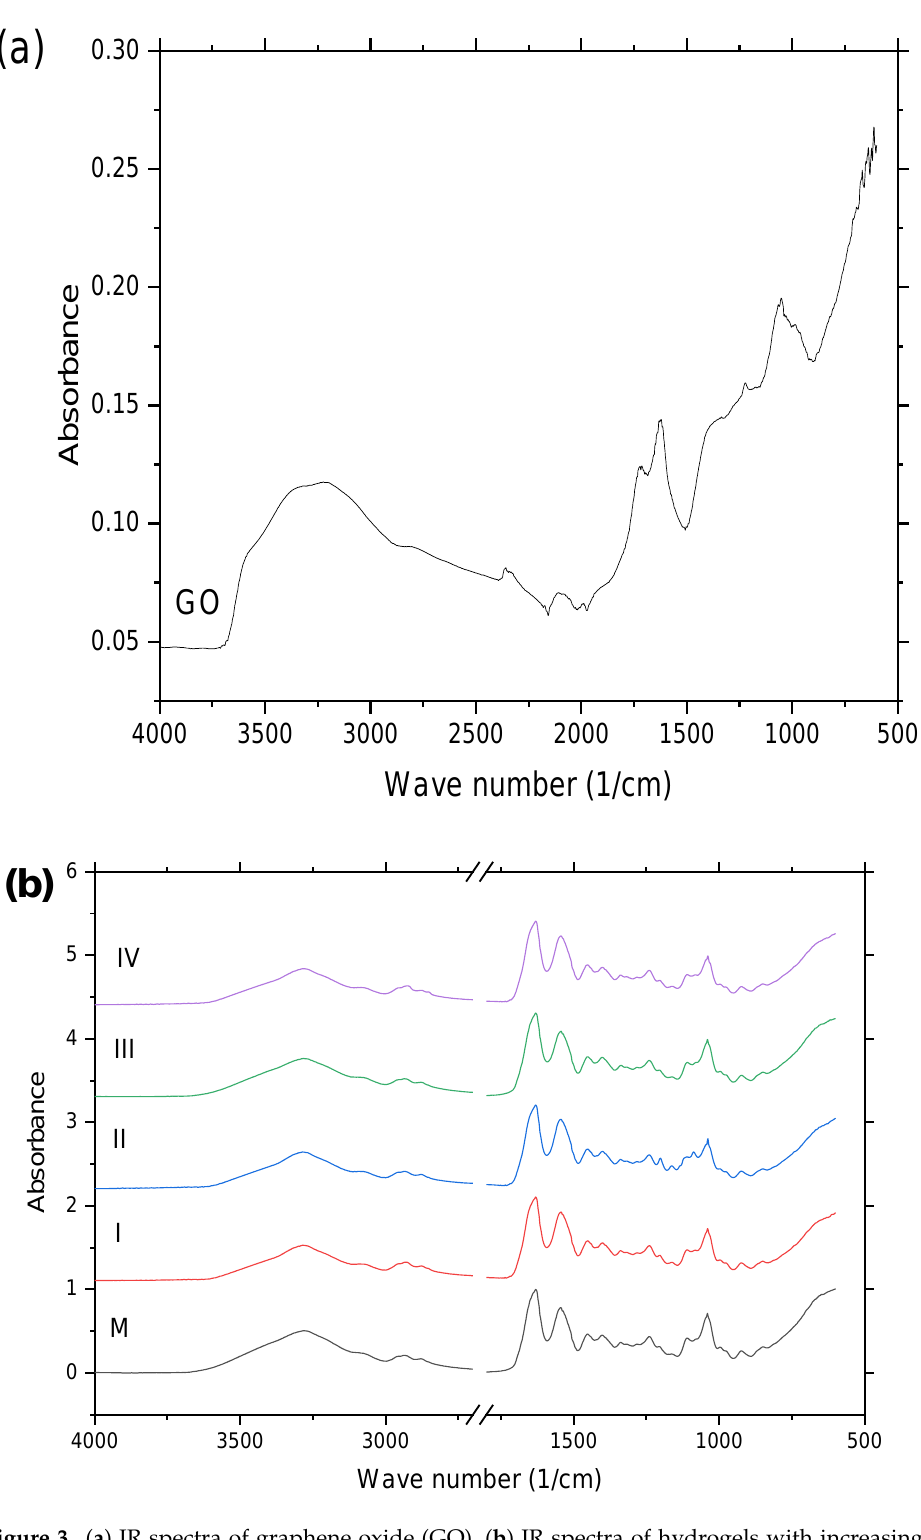
Figure 3. ( a ) IR spectra of graphene oxide (GO), ( b ) IR spectra of hydrogels with increasing GO concentration (I, II, III, and IV), and without GO (M).